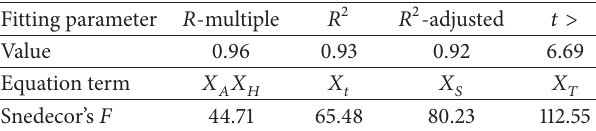
Table 3: Values of statistical parameters for the fitting of experimen- tal data (Kappa number) to